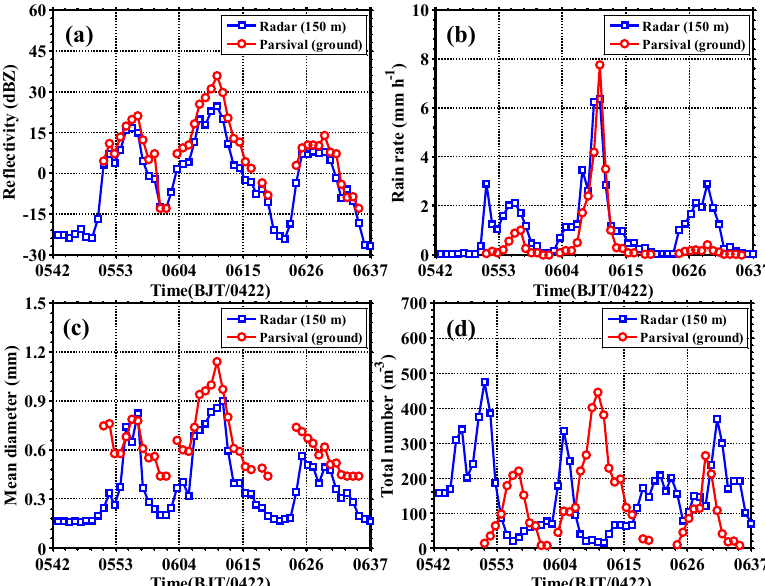
Figure 14. Time series of ( a ) reflectivity, ( b ) rain rate, ( c ) particle mean diameter, and ( d ) total number concentration measured by the MMCR (at the first available range gate, 150 m) and Parsivel (on the ground).